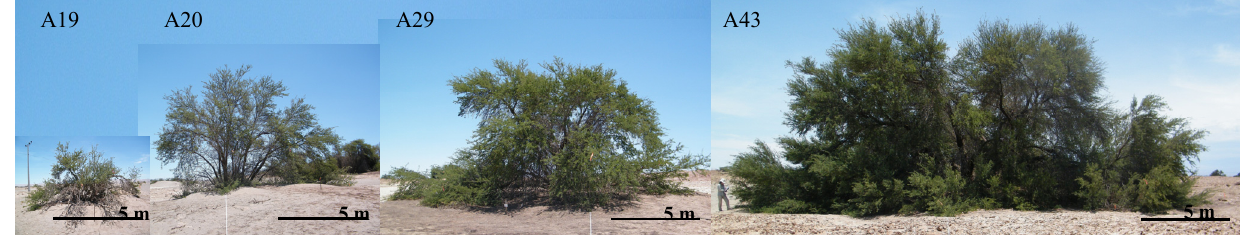
Figure 5. Examples of Tamarugo trees at the Llamara site. Tamarugos are sorted according to the proximity to the pumping area (left one, the closest).